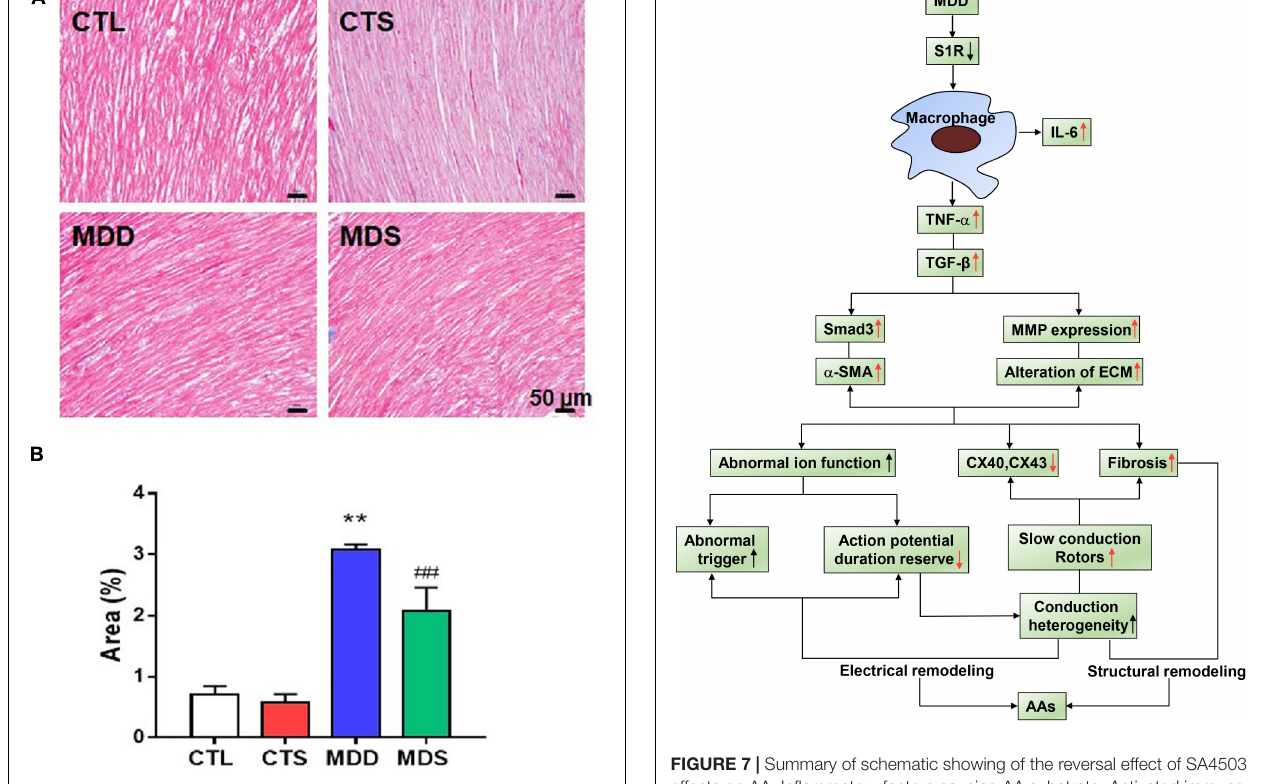
FIGURE 6 | Atrial myocardial fibrosis. (A) Atrium slices stained with Masson stain (original magnification: 200 × ). (B) Quantification of the fibrotic area in each group ( n = 5). ∗∗ P < 0.01 vs. CTL group; ## P < 0.01 vs. MDD group.